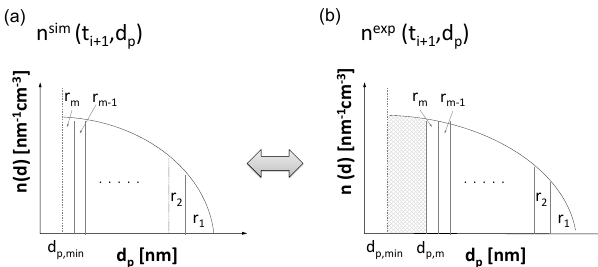
Figure 1. Schematic comparison of defined regions r i =[ 1 ,m ] of the simulated n sim (cid:0) t j + 1 ,d p (cid:1) (a) and experimental n exp (cid:0) t j + 1 ,d p (cid:1) (b) number-size distributions allows for the determination of the growth rate. Particle diameter is plotted on the abscissa; particle number-size distribution is plotted on the ordinates of the graphs. The shaded area on the right-hand graph depicts the particles that grew beyond the minimum diameter d p , min within the last time span (cid:49)t = t j + 1 − t j . Particles of size d p , min at time t j are of size d p ,m at time t j + 1 (see right-hand